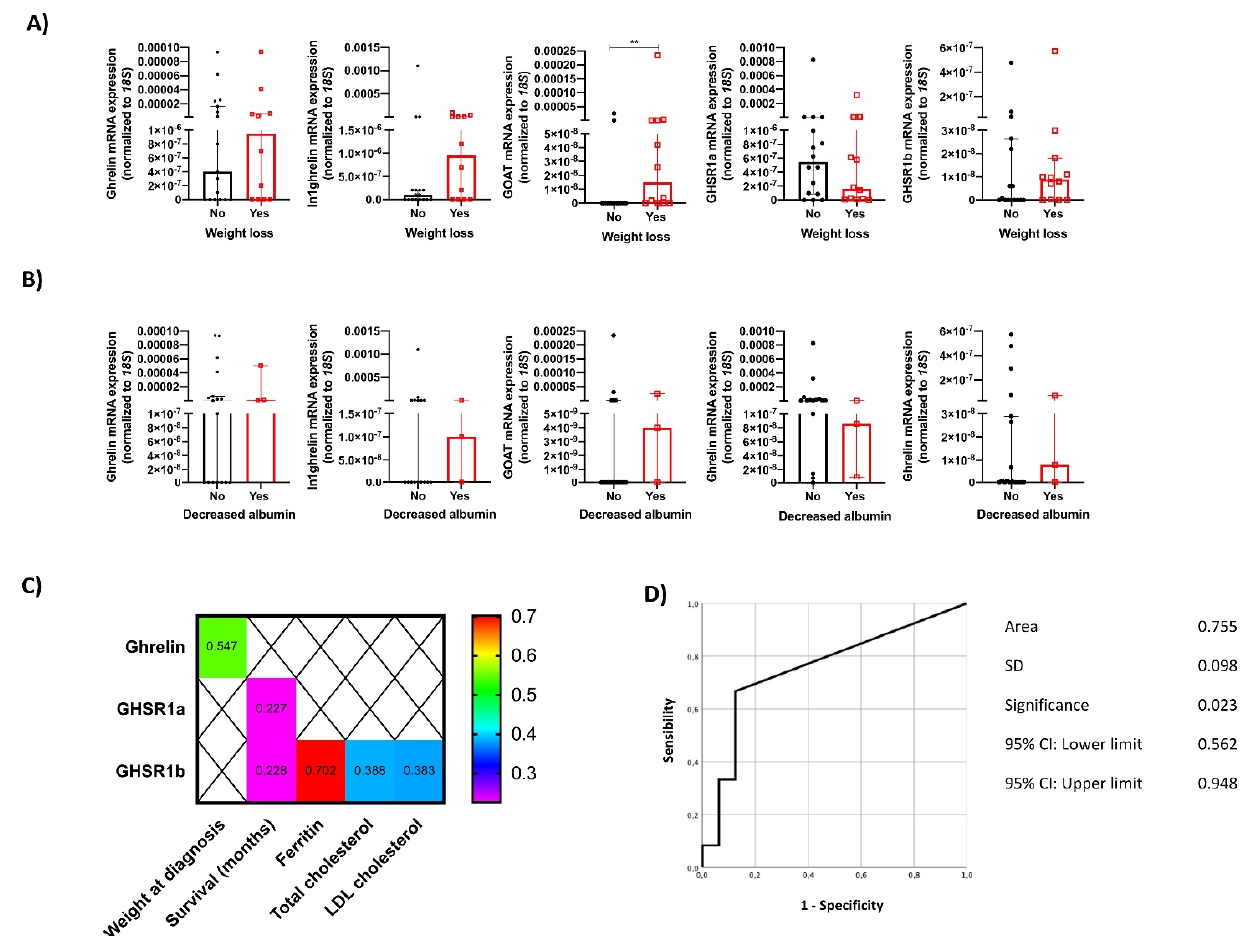
Figure 3. Molecular expression of ghrelin system components in NEN tumor samples according to the presence of: ( A ) weight loss; ( B ) decreased serum albumin levels; ( C ) significant clinical correlations between the mRNA expression of some ghrelin system components and nutrition-related parameters in NENs; ( D ) ROC curve representing GOAT enzyme as marker for identifying NEN patients with weight loss. **: p < 0.01